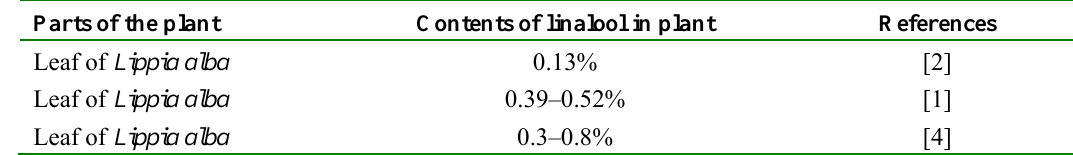
Table 2. The contents of linalool (%, weight) in the plant Lippia alba